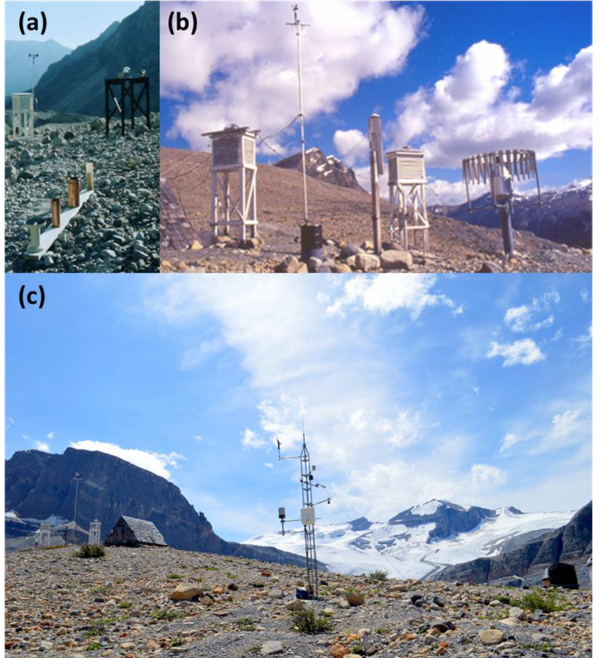
Figure 4. The base camp stations: (a) Peyto Main IHD, July 1970; (b) Peyto Main Old (July 2009); (c) Peyto Main (Septem- ber 2015) (Peyto Main Old in left background). Photographs by D. Scott Munro (a, b) and May Guan (c) .